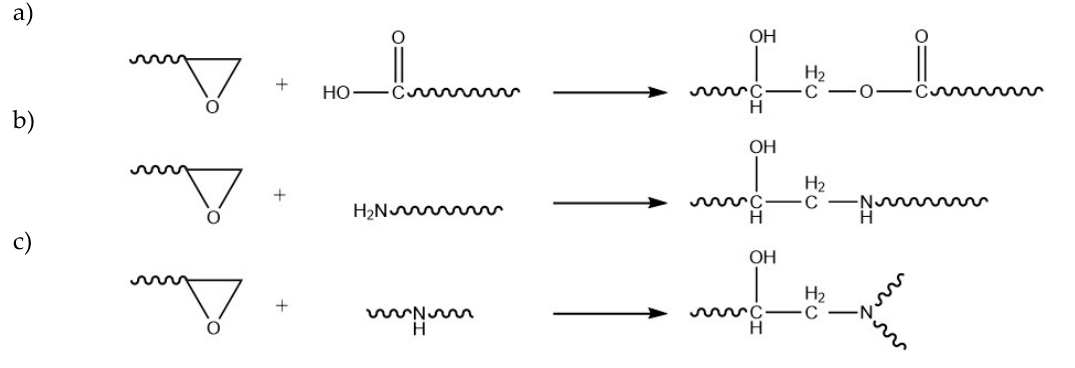
Figure 2. Possible reactions of the epoxy group and polyamide 12. Reaction between ( a ) epoxy- and carboxyl group and ( b/c ) epoxy- and amine groups.